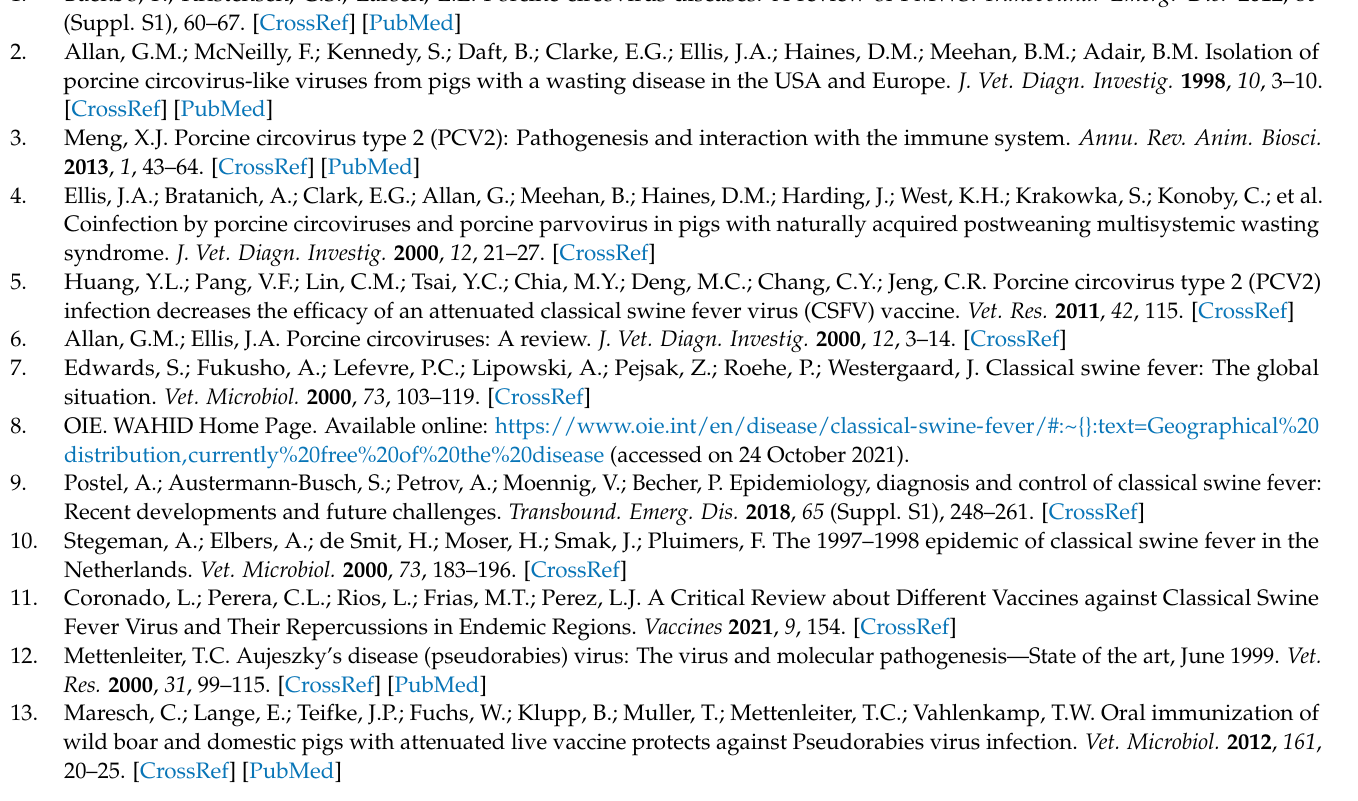
temperature; Table S3: Bodyweight (in pounds); Table S4: PRVtmv+ vaccine virus replication in immunized pigs (nasal and tonsil swabs)-PRV-specific qPCR and virus isolation in swine kidney cells (in PRVtmv+ immunized pigs); Table S5: a. PRV-neutralizing antibody titer; b. PCV2b-neutralizing antibody titer; c. CSFV-neutralizing antibody titer; Table S6: Percent changes in leukocytes and lymphocytes count; Table S7: Fecal PCV2b shedding. PCV2b-capsid gene-specific qPCR assay; Table S8: a. PCV2b-viremia in serum. PCV2b-capsid gene-specific qPCR assay; b. PBMC-associated PCV2b viremia. PCV2b-capsid gene-specific qPCR assay; Table S9: Quantification of PCV2b viral genome copies in pig’s lymphoid